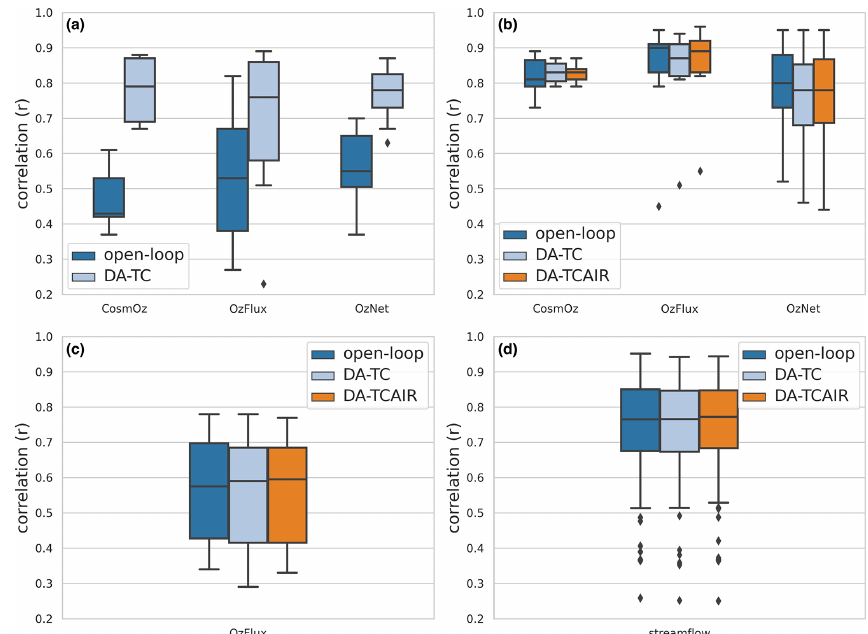
Figure 7. Distribution of correlation statistics of AWRA-L water balance estimates against in situ measurements of (a) surface soil moisture, (b) root-zone soil moisture, (c) evapotranspiration and (d) streamflow.